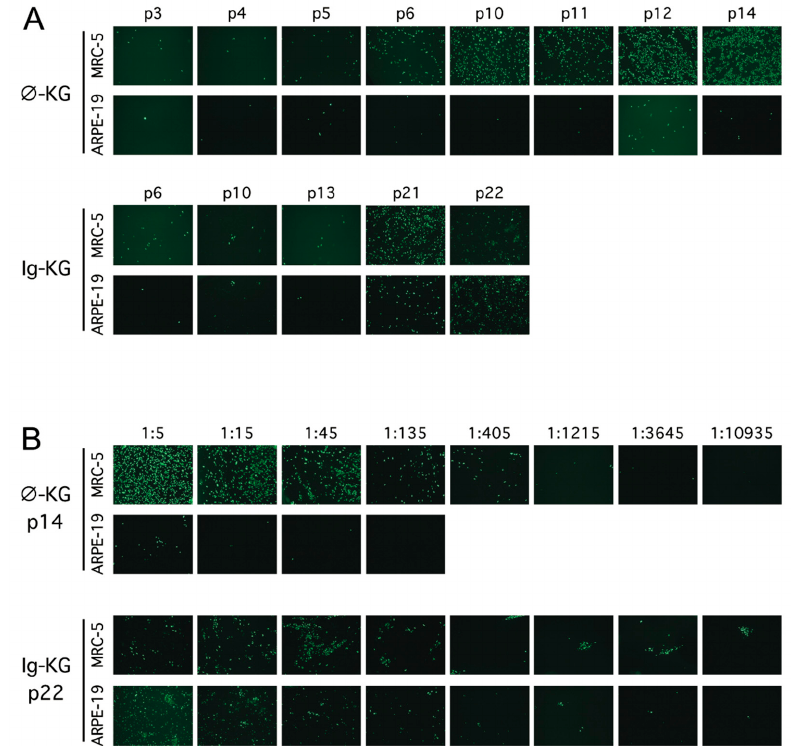
Figure 1. A clinical CMV isolate passaged in the presence of antibodies retains epithelial tropism. ( A ) MRC-5 fibroblasts or ARPE-19 epithelial cells were infected with replicate virus stocks from the indicated passages of φ -KG (clarified culture medium) or Ig-KG (infected cell sonicates) and stained for CMV IE1/IE2 after three days. ( B ) The φ -KG passage 14 stock and Ig-KG passage 22 stock were serially diluted, added to MRC-5 fibroblasts or ARPE-19 epithelial cells, and stained for CMV IE1/IE2 antigens after three days. Images were taken using a 10 ×